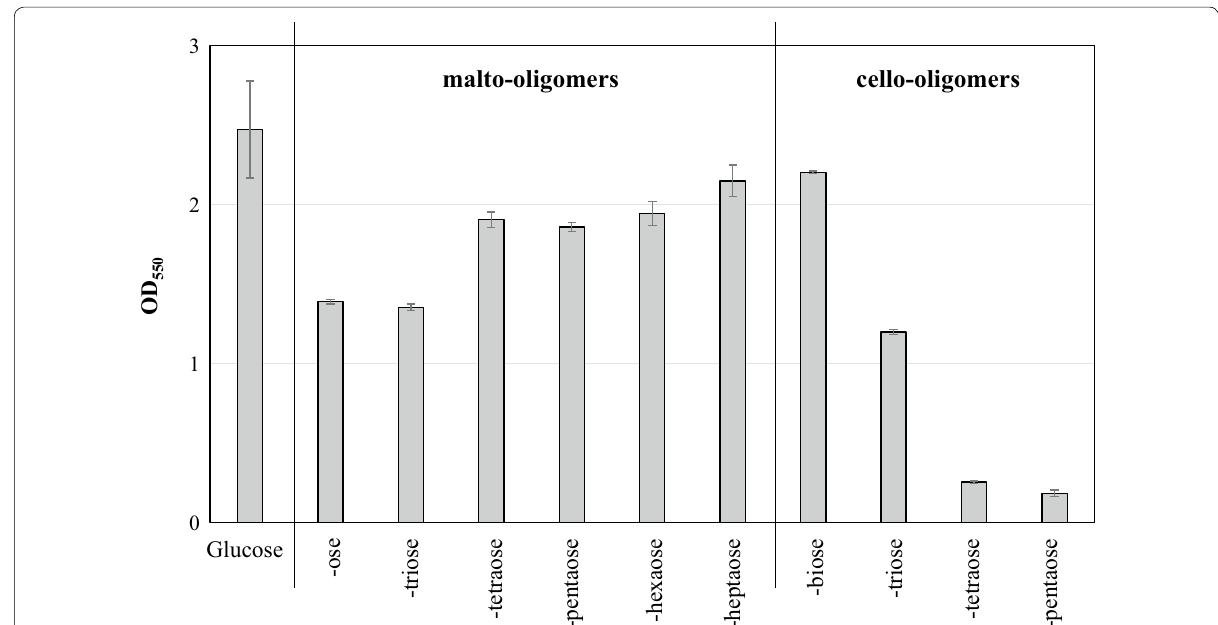
Fig. 3 Growth on pure malto- and cello-oligomers as sole carbon source. E. coli KO11 indicated carbon source at 37 °C with shaking at 200 rpm for 48 h. Glucose, all of the malto-oligomers and cellobiose were added to 0.50 wt%. Cellotriose, cellotetraose, and cellopentaose were added at 0.10 wt%. Values are the average of three biological replicates, with error bars indicating one standard